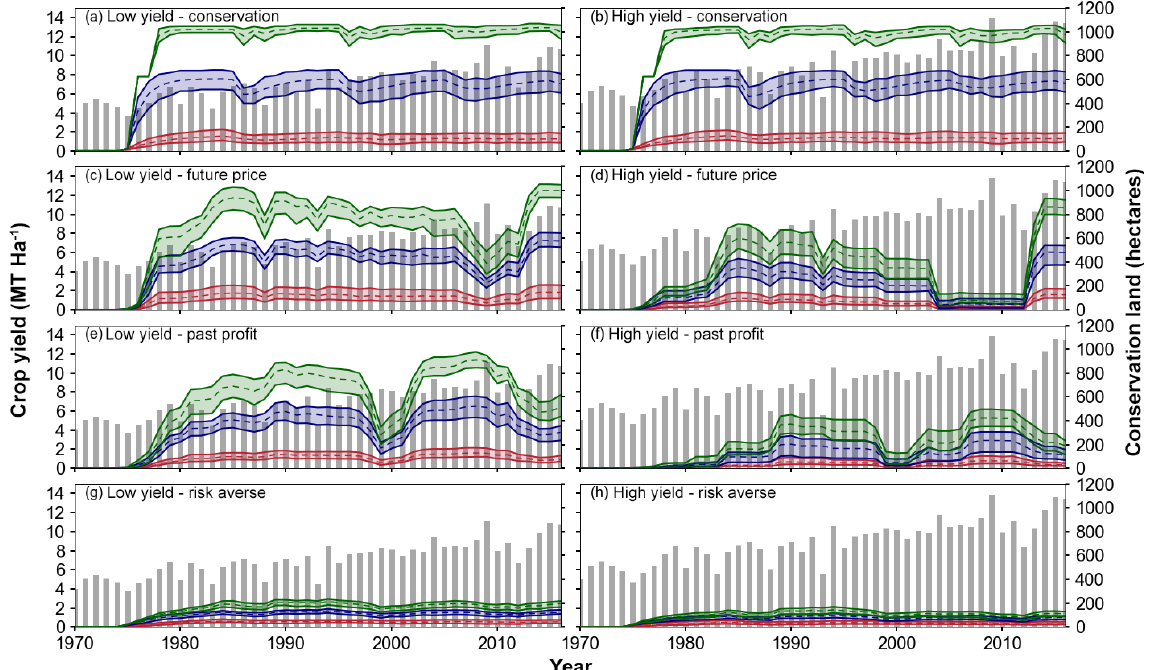
Figure 10. Range of simulated conservation land within the watershed with low (a, c, e, g) and high (b, d, f, h) crop yields for conservation- minded populations (green), mixed populations (blue), and production-minded populations (red). Yearly crop yields are plotted as bars for the crop yield scenario. Results are for decision schemes of 80% weight on conservation behavior (a, b) , 80% weight on future price (c, d) , 80% weight on past profit (e, f) , and 80% weight on risk aversion (g, h)